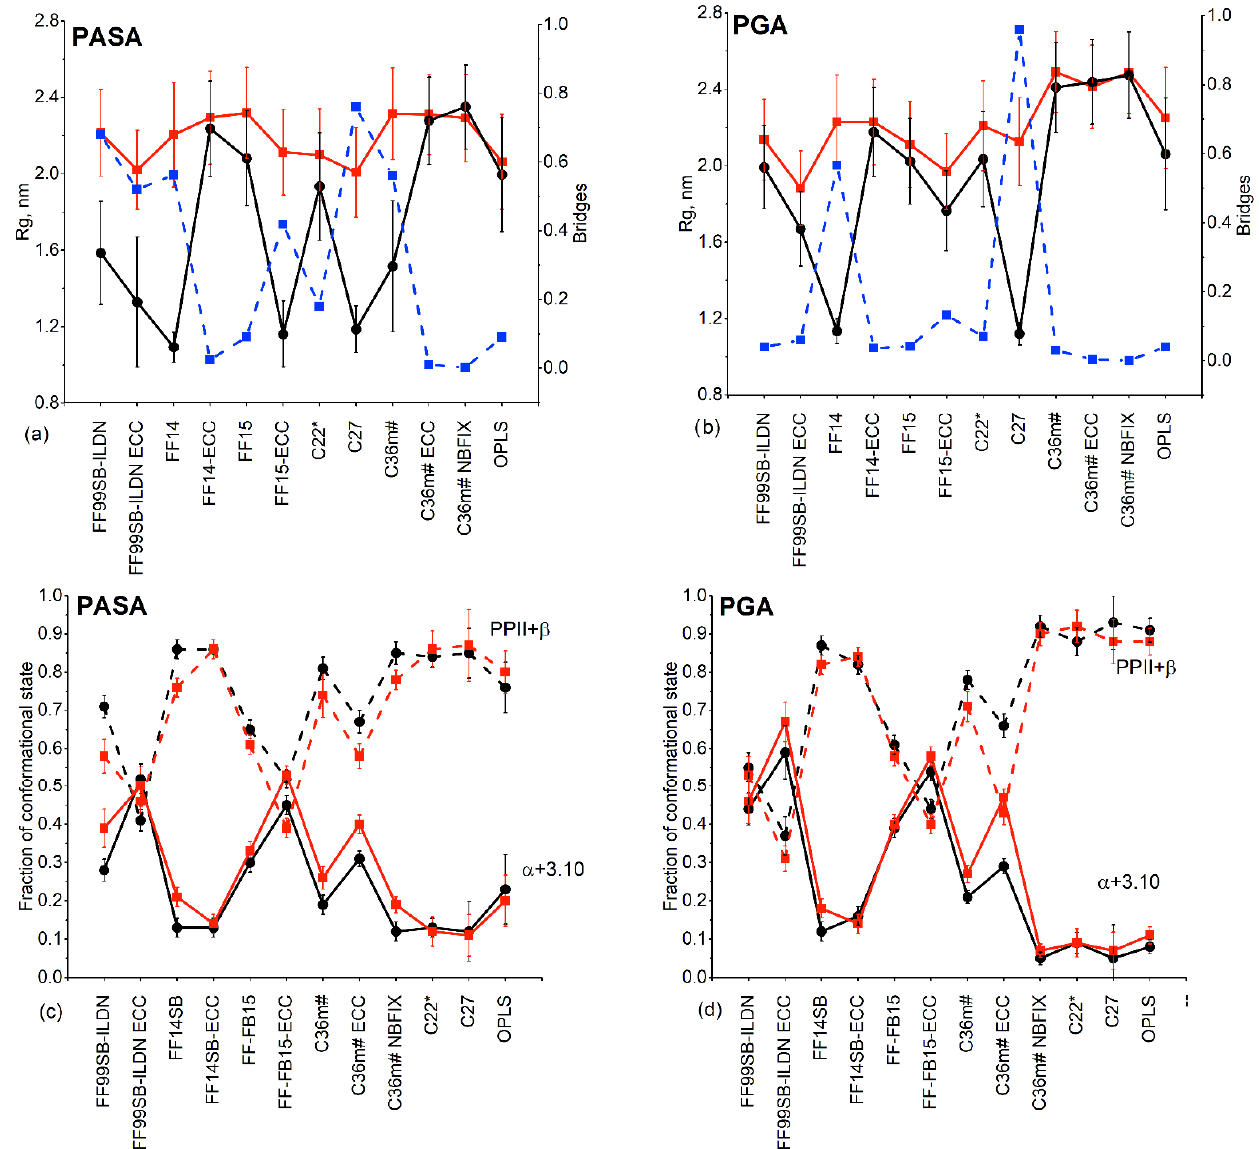
Figure 9. R g (solid lines) and the fraction of carboxyl groups involved in the Na + bridges formation (dashed lines) for ( a ) PASA and ( b ) PGA. The fractions of the stretched (solid lines) and screw (dashed lines) conformations for ( c ) PASA and ( d ) PGA. Black lines indicate the systems with Na + , red lines the systems with K + . Blue lines show fractions of carboxyl groups connected by Na + bridges.